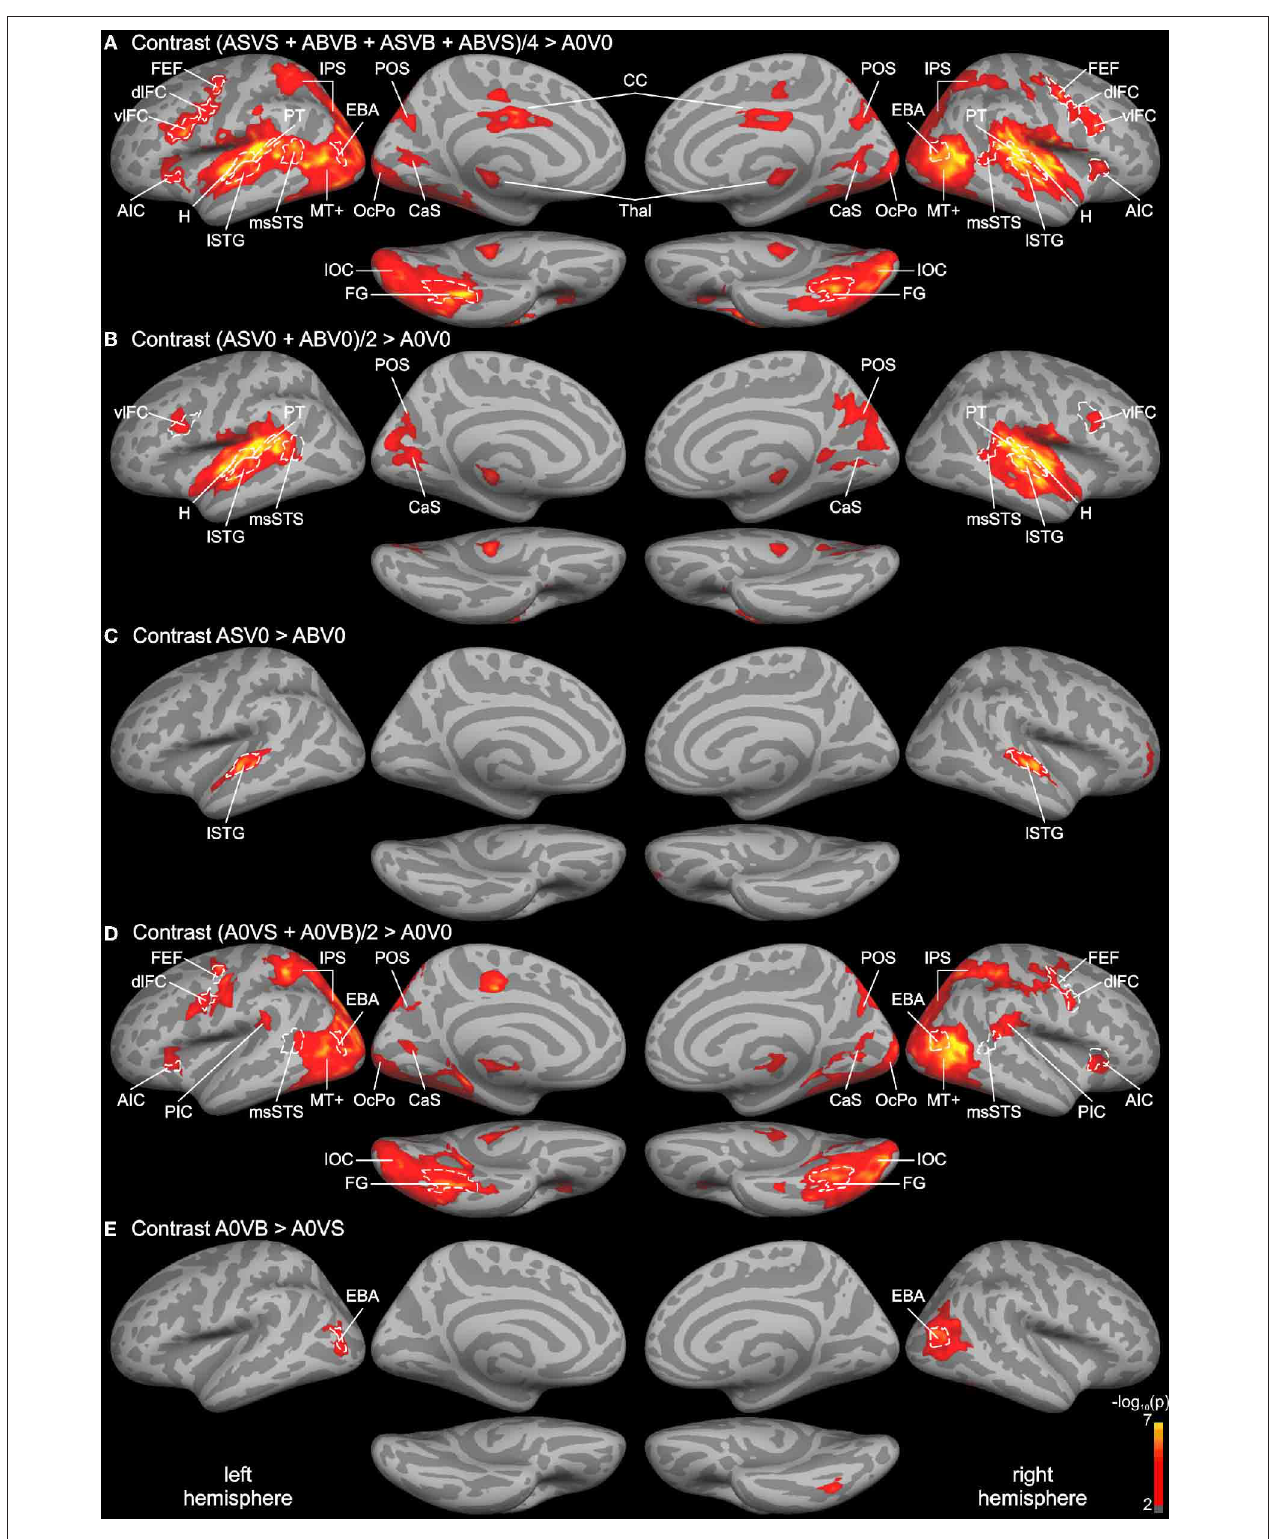
FIGURE 2 | Whole-brain group analysis statistical parametric maps overlaid on cortical surfaces of the MNI standard brain. Both left and right hemispheres are shown from a lateral, medial, and inferior view. Five relevant contrasts are shown: (A) Contrasting BOLD responses to all